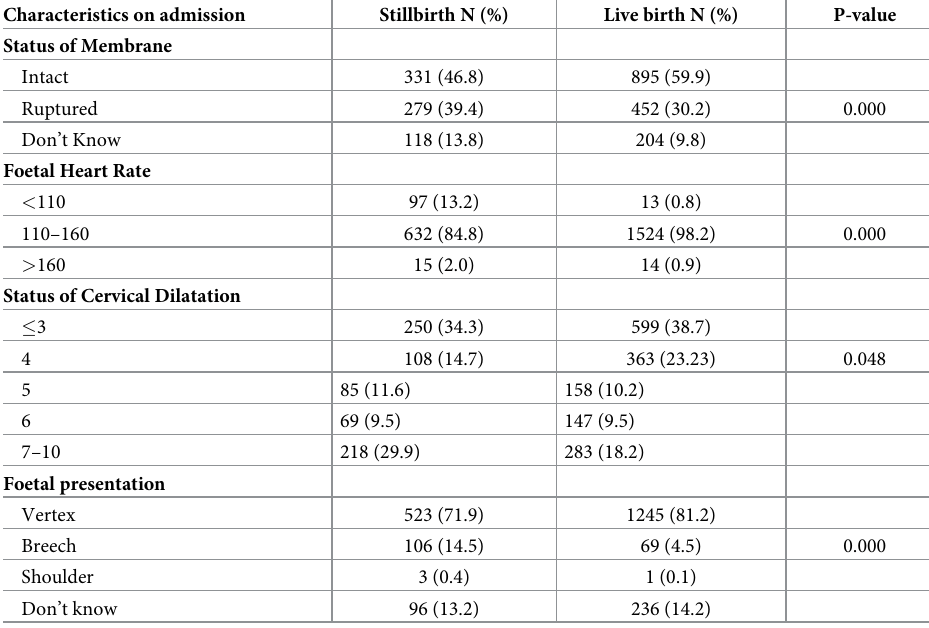
Table 2. Distribution of labour admission assessment indicators across cases and